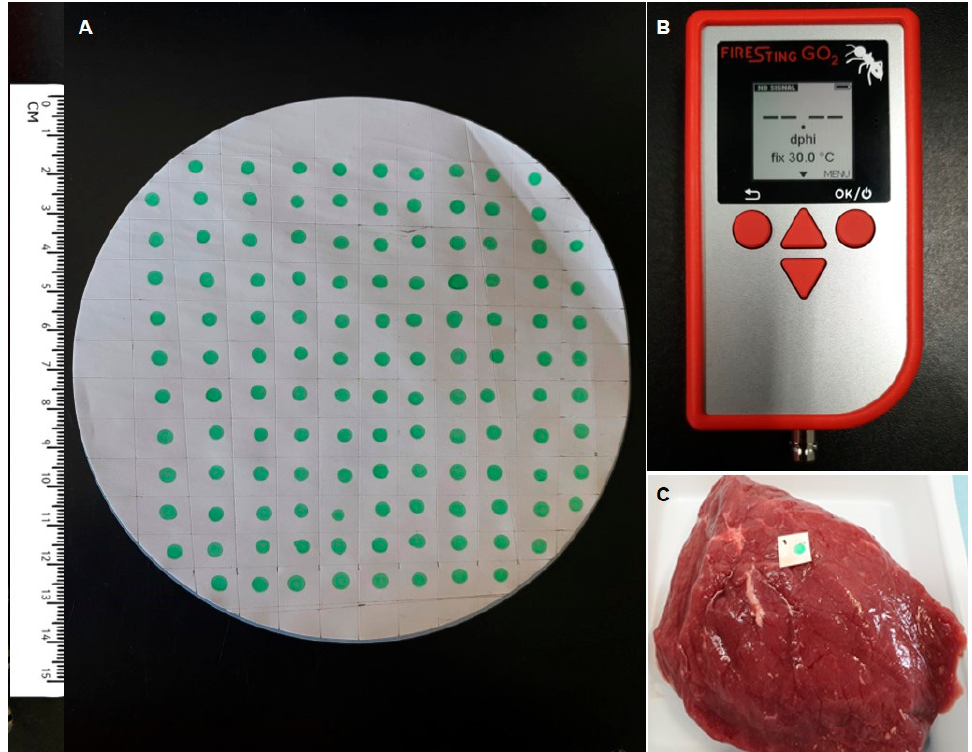
Figure 1. The low ‐ cost O 2 sensor system and measurement setup. ( A ) The array of sensor dots on the PVDF membrane. ( B ) The FirestingGo2 handheld reader used to measure sensor signals (dphi°) and convert them into the O 2 concentration (kPa or %). ( C ) A disposable sensor dot placed on a meat cut prior to vacuum packaging.